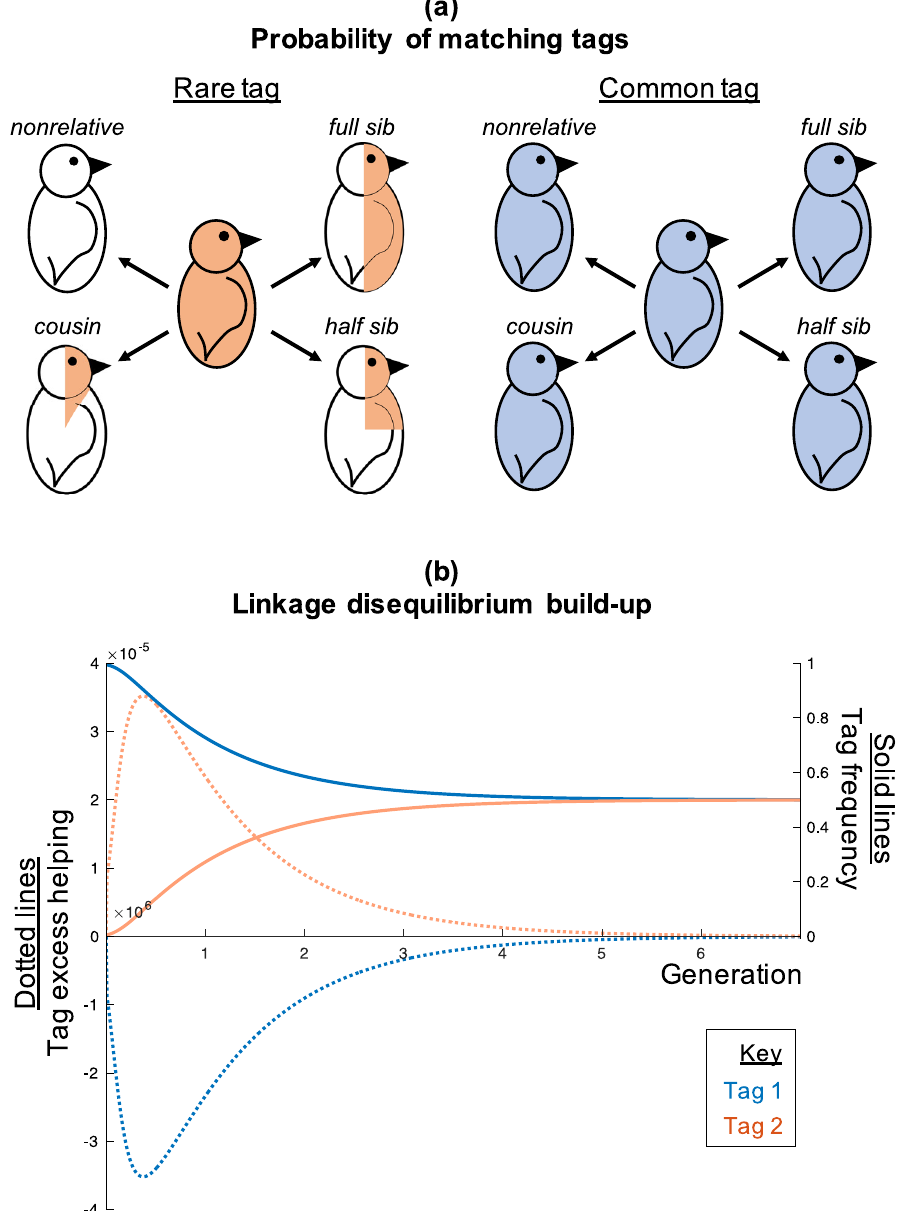
Fig. 3 Advantage for rare tags. a For birds with rare tags (orange), the probability of matching tags with someone (proportion shaded) is given by pedigree relatedness. For birds with common tags (blue), the probability of matching tags with someone (proportion shaded) is always high, regardless of pedigree relatedness. More common tags are therefore worse indicators of both relatednesses at the trait locus and pedigree relatedness. b An illustrative single trial, with two tags (blue and orange). The solid lines show tag frequency and the dotted lines show the probability above the population average that a social interaction results in help being received (tag excess helping) (see ‘ De fi nition of tag excess helping plotted in Fig. 3b ’ ). The initially rare tag (orange) is a better indicator of relatedness, and as a result, it gains extra helpers (orange dotted line increases) relative to the initially common tag (blue dotted line decreases) (linkage disequilibrium). This causes the rare (orange) tag to increase in frequency (orange solid line increases), and the common (blue) tag to decrease in frequency (blue solid line decreases). As the orange tag increases in frequency, it loses its extra helpers (dotted lines tend to zero), and the fi tness of the two tags converge. We assumed L = 2, µ = 0.0001, b = 0.015, c = 0.005, α = 1, c = 0, m = 0.3, r = 0.1, N = 30. Bird cartoons max Trait search adapted from Levin, Caro, Grif fi n & West, Evolution Letters (ref. 59 ), Creative Commons